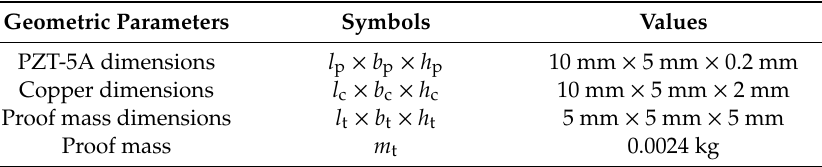
Table 1. Initial geometric parameters of the CB.